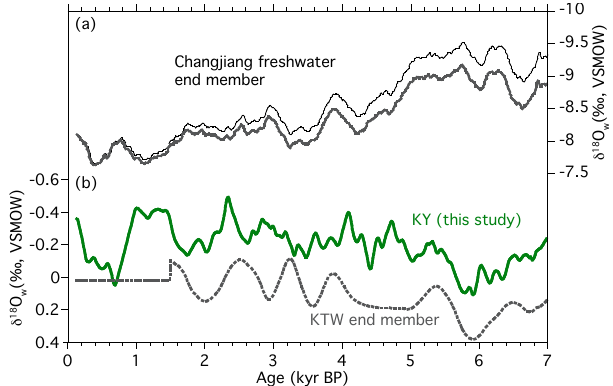
Figure 8. (a) δ 18 O w of the Changjiang freshwater end member cal- culated from a speleothem in Heshang Cave in China (Hu et al., 2008). (b) δ 18 O w of marine cores in the northern ECS (KY07-04- 01, in green) and end member of Kuroshio Taiwan Water (KTW, gray dotted